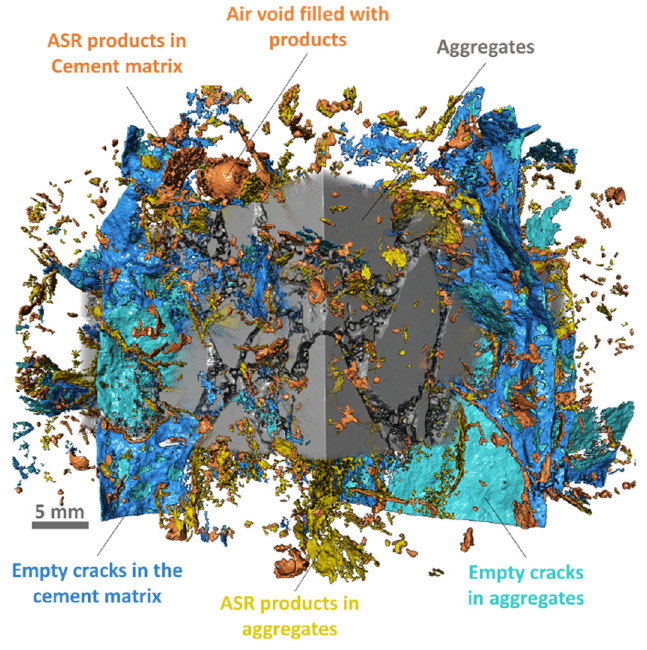
Figure 16. 3D rendering of the volumes of the segmented empty cracks inside aggregates (in cyan) and inside the cement matrix (in blue), respectively, and of the segmented ASR products, distinguishing between inside aggregates (in yellow) and inside the cement matrix (in orange) as well. Only part of the volume of the segmented aggregates is shown in semi ‐ transparent grey, to allow seeing the extent of the other volumes. Notice that part of the products volume did not consist of cracks but of other types of pores, e.g., air voids. The specimen was the same as for Figure 15 and the tomogram in the time series was the one at 250